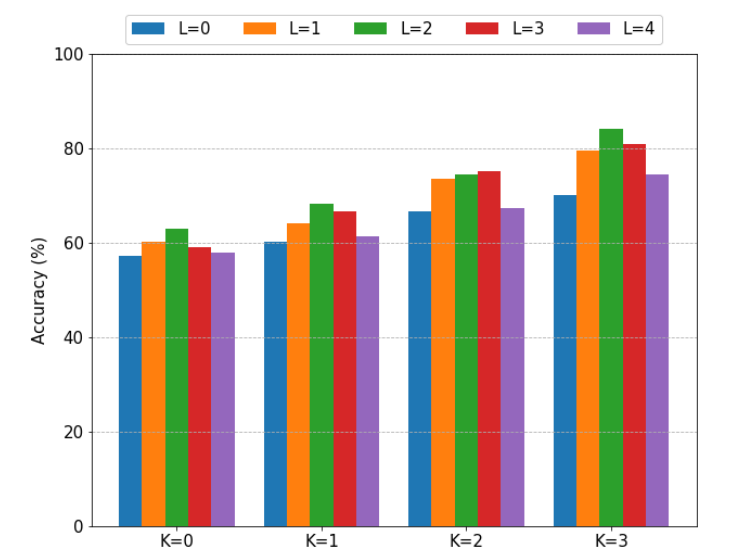
Figure 6. Effect of data augmentation on fragment classification performance (fragment length